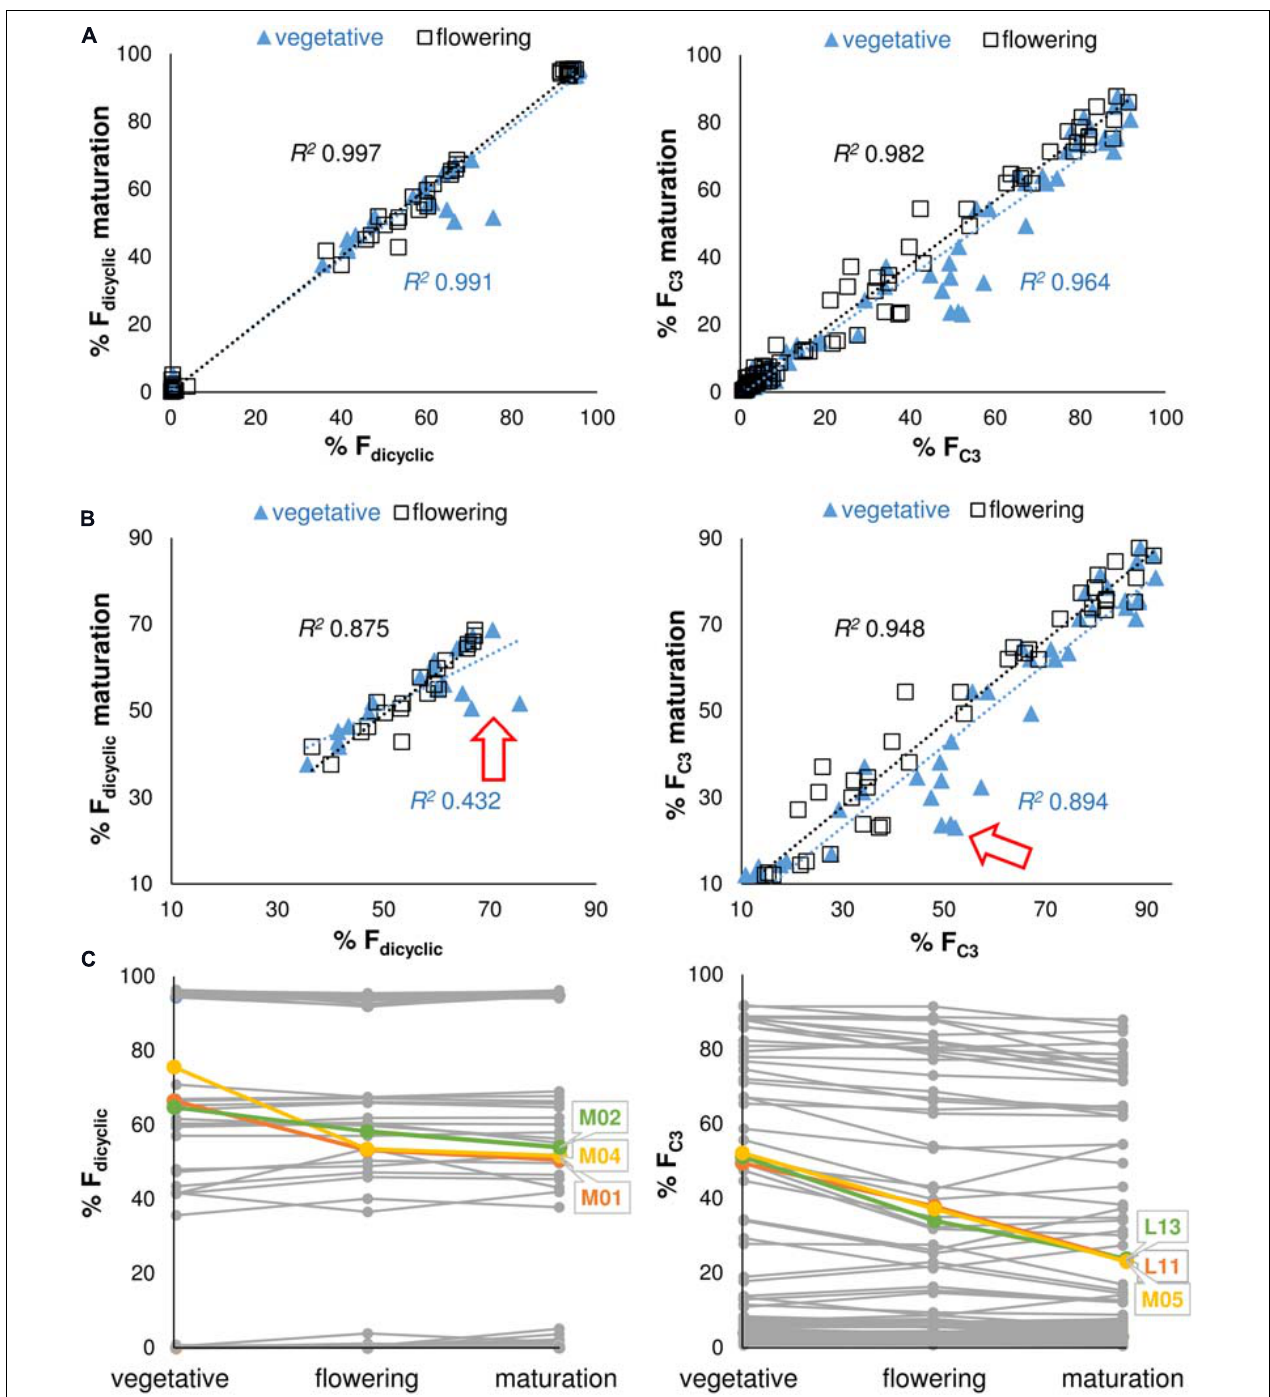
FIGURE 4 | (A) Regression analysis of the F dicyclic as well as the F C3 chemotypic values between developmental stages. F dicyclic as well as the F C3 values describe dicyclic as well as C3-alkyl cannabinoid fractions. The F dicyclic as well as the F C3 chemotypic values on the x -axis describe cannabinoid fractions at the vegetative and flowering stages. (B) Regression analysis of the truncated F dicyclic as well as F C3 values between developmental stages. The F dicyclic as well as the F C3 chemotypic values on the x -axis describe dicyclic as well as C3-alkyl cannabinoid fractions at the vegetative and flowering stages. (C) Individual plants with large standardized residuals across vegetative and maturation growth stages. The F dicyclic as well as the F C3 chemotypic values on the y -axis describe dicyclic as well as C3-alkyl cannabinoid fractions across developmental stages. Red arrow indicates position of units with large standardized residuals; Letters specify accession ID ( Table 1 ); Numbers indicate plant individual within accession; C 5 -alkyl cannabinoid fractions (F C5 ); C 3 -alkyl cannabinoid fractions (F C3 ); dicyclic cannabinoid fractions (F dicyclic ); and tricyclic cannabinoid fractions (F tricyclic ).